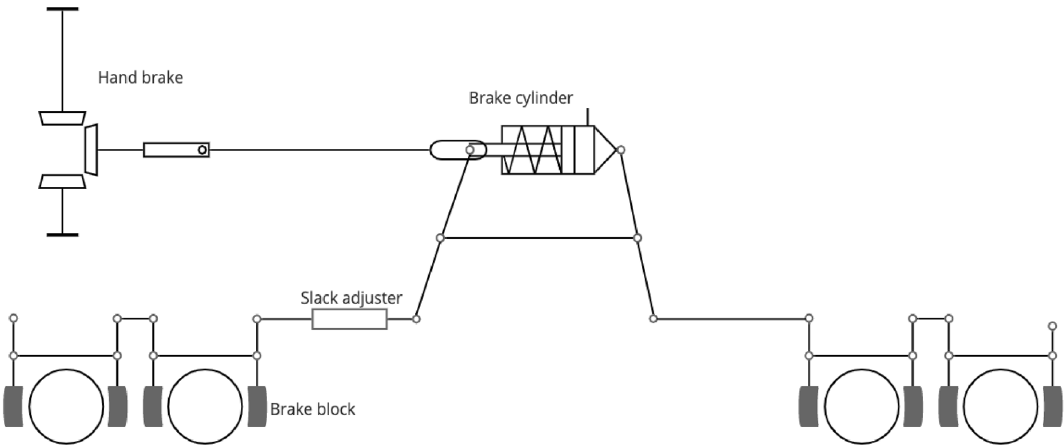
Fig. 3 Braking force